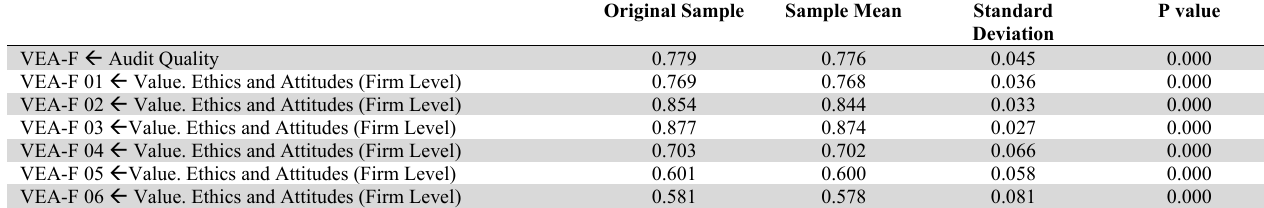
The Manifestation of Attributes of Values, Ethics and Attitude for Engagement (Public Accounting Firm)